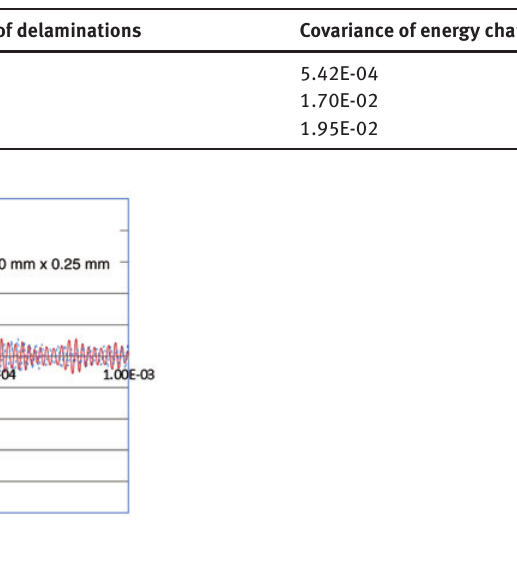
Figure 31: Wave response comparison for a beam with multiple damages.